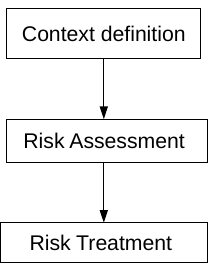
Figure 1. Risk assessment